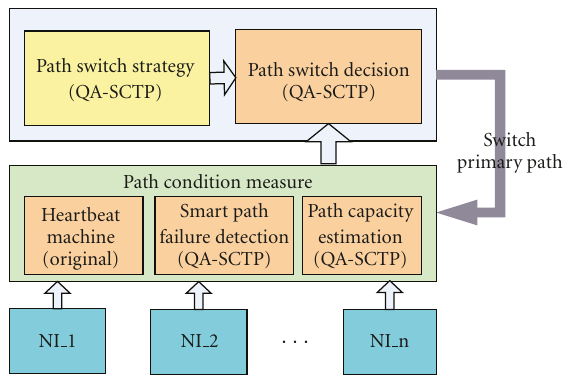
Figure 3: Quality-aware SCTP path management mechanism.